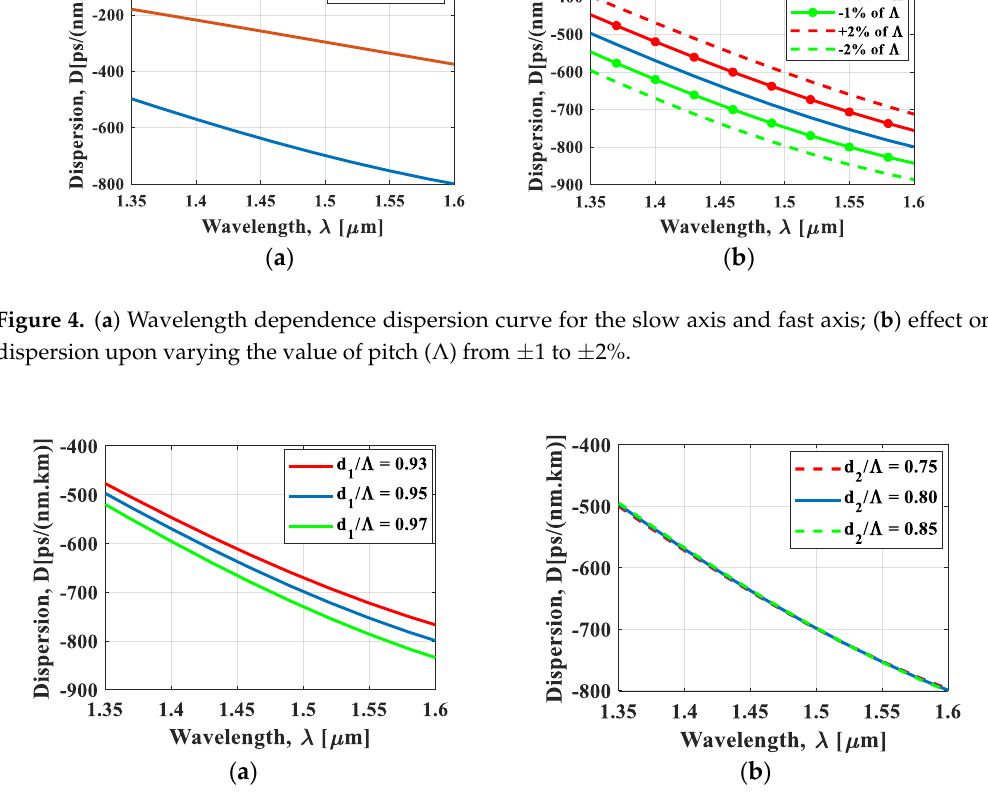
Figure 5. Effect of changing ( a ) d 1 /Λ on the dispersion characteristics, when the remaining parameters ( Λ = 0.76 and d 2 /Λ = 0.80 ) were kept constant; and ( b ) d 2 /Λ on the dispersion characteristics, when the remaining parameters ( Λ = 0.76 and d 1 /Λ = 0.95 ) were kept constant.